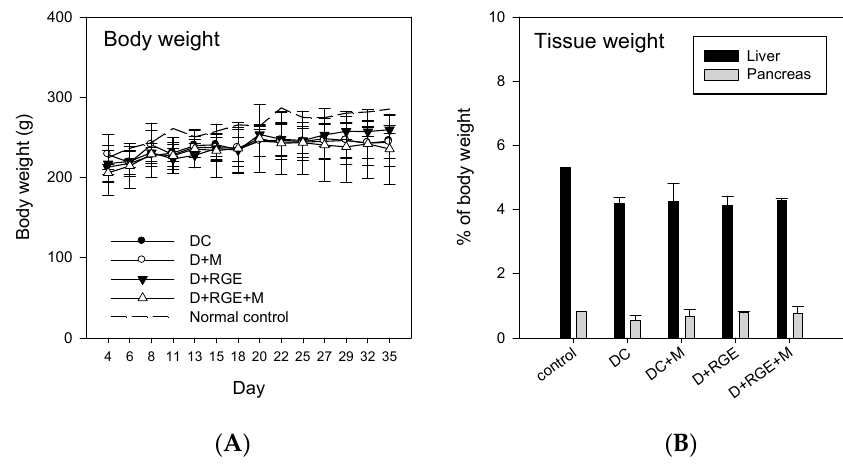
Figure 4. Effects of oral administration of metformin and red ginseng extract (RGE) alone or combined on body ( A ) and liver or pancreas ( B ) weights in normal control, streptozotocin (STZ)-induced diabetic group (DC), diabetic rats treated with metformin (D + M, 50 mg/kg/day), diabetic rats supplemented with RGE (D + RGE, 2 g/kg/day), and diabetic rats treated with metformin and RGE (D + RGE + M). Data points and bars are means ± SD of four rats per group.